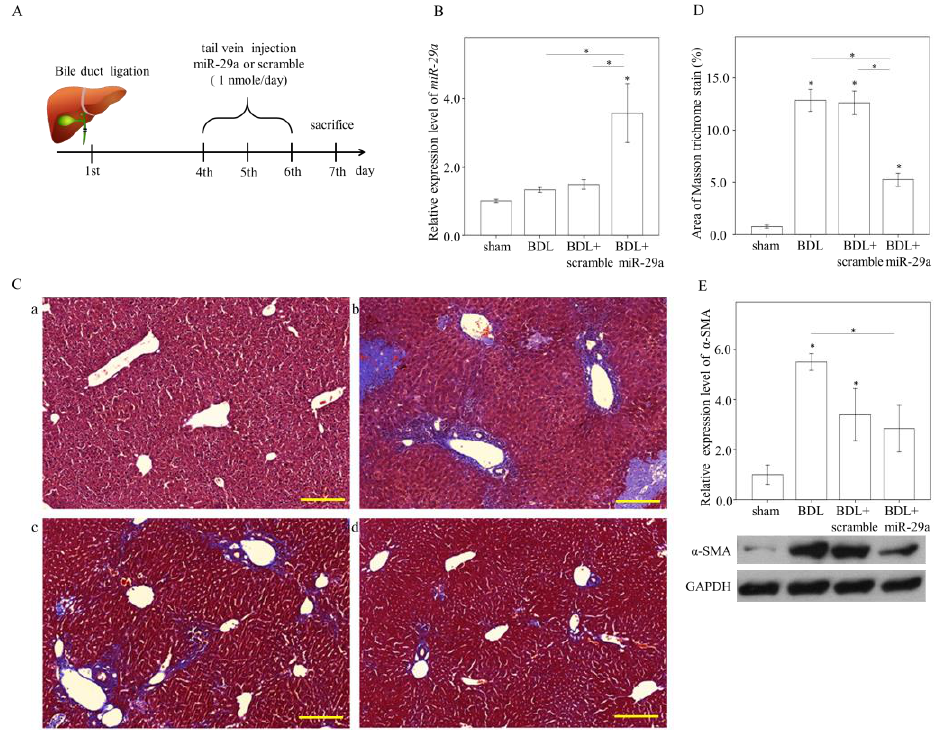
Figure 1. Exogenous miR-29a injection significantly reduces liver fibrosis in the context of BDL. ( A ) Experimental procedure. ( B ) quantitative real-time PCR (qRT-PCR) results of miR-29a levels in liver specimens. N = 6 – 13. ( C ) Representative image of Masson trichrome staining. a: sham, b: BDL, c: BDL